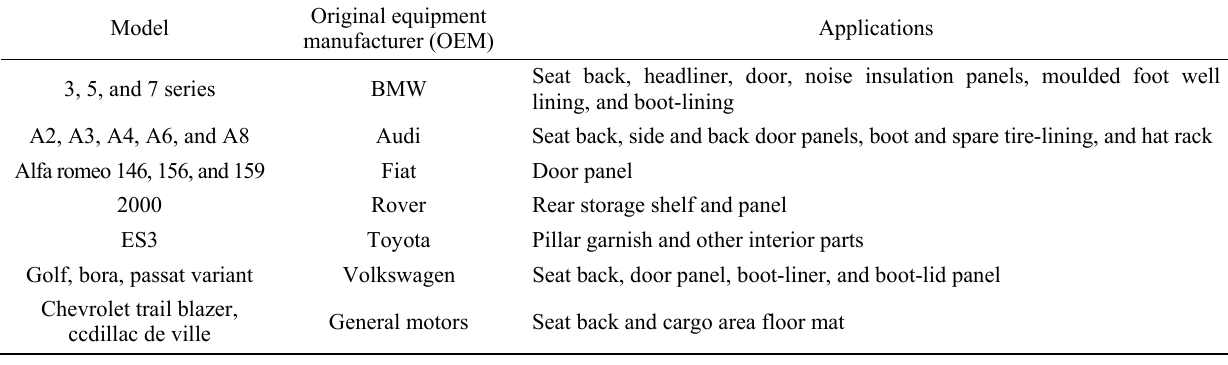
Table 1 Applications of natural fiber reinforced composites in automotive industry [3].